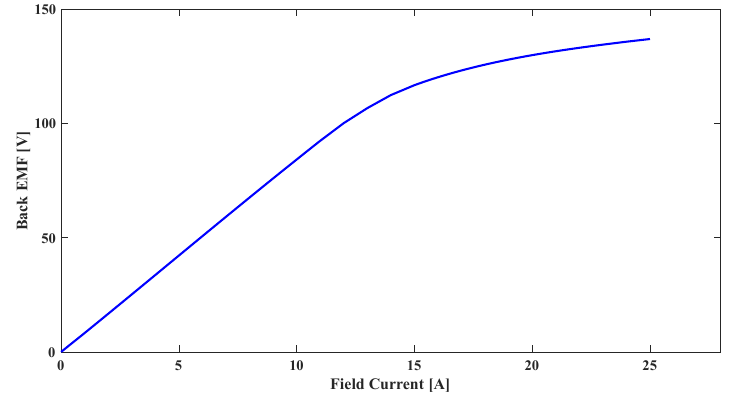
Figure 8. The characteristics curve between Back EMF and field current.